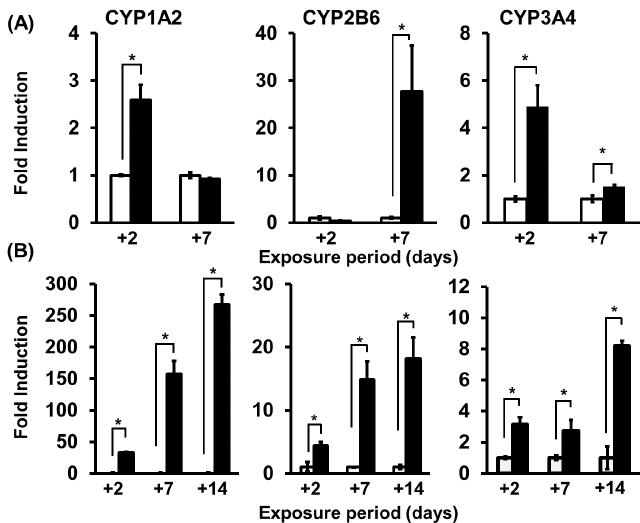
Figure 5. Induction of enzymatic activity of CYP1A2, CYP2B6, and CYP3A4/5 in 2D- and 3D-cultured hepatocytes. ( A ) 2D culture. Two days after seeding, human hepatocytes were exposed to inducers; 100 μM of omeprazole for CYP1A2, 1 mM of phenobarbital for CYP2B6, or 10 μM of rifampicin for CYP3A4/5. DMSO (0.1%) was used as vehicle control. After exposure to test compounds for 2 and 7 days, enzyme activity was measured (phenacetin O-demethylation to form acetaminophen, bupropion hydroxylation to form hydroxybupropion, and midazolam hydroxylation to form 1′-hydroxymidazolam). ( B ) On day 7, after formation of 3D structures, hepatocytes were exposed to inducers, and enzyme activities were measured as above. Open and closed columns represent the activity of each CYP enzyme when cells were exposed to DMSO (0.1%) or inducers for 2, 7, and 14 days. The columns indicate the mean ± SEM ( n = 3–4) of fold induction versus the control. * significant differences from the control ( p < 0.05). Reproduced with permission from Biol. Pharm. Bull. Vol. 40 No. 7. pp 967–974 [55]. Copyright 2017 The Pharmaceutical Society of Japan.